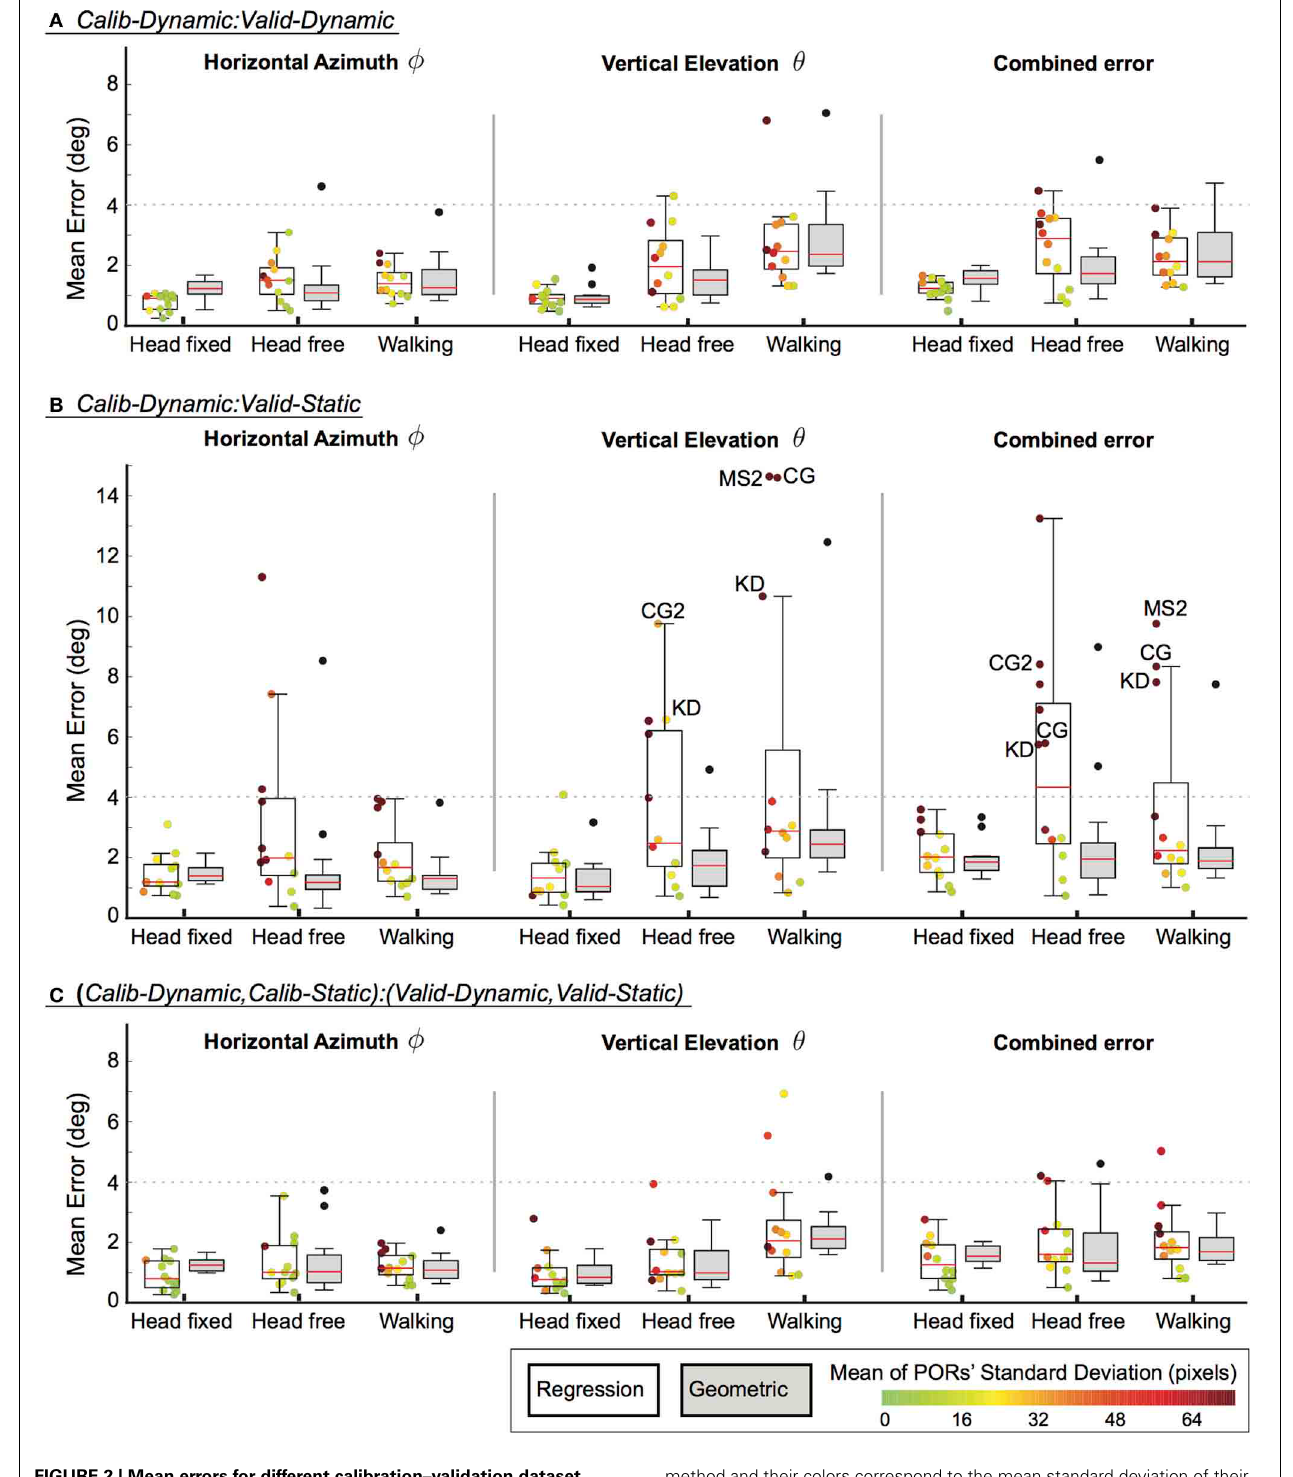
method and their colors correspond to the mean standard deviation of their estimated PORs. Dotted lines are provided to indicate the calibration accuracy of previous work. (A) Calib-Dynamic:Valid-Dynamic; (B) Calib-Dynamic:Valid- Static; (C)